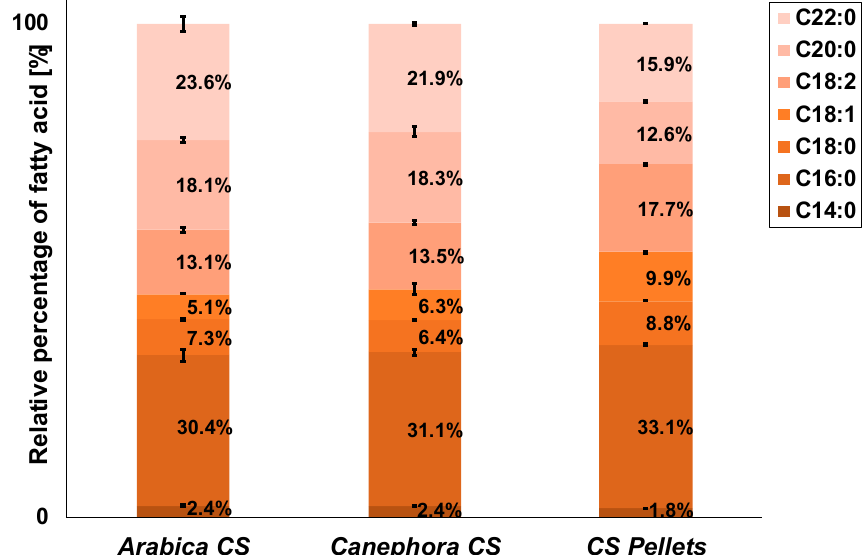
Figure 4. Fatty acid composition of lipids from coffee silver skin from Coffea arabica ( arabica CS) and Coffea canephora ( canephora CS) as well as coffee silver skin pellets (CS pellets); percent of total fatty acids. C14:0 myristic acid; C16:0 palmitic acid; C18:0 stearic acid; C18:1 oleic acid; C18:2 linoleic acid; C20:0 arachidic acid; C22:0 behemic acid; n = 2.